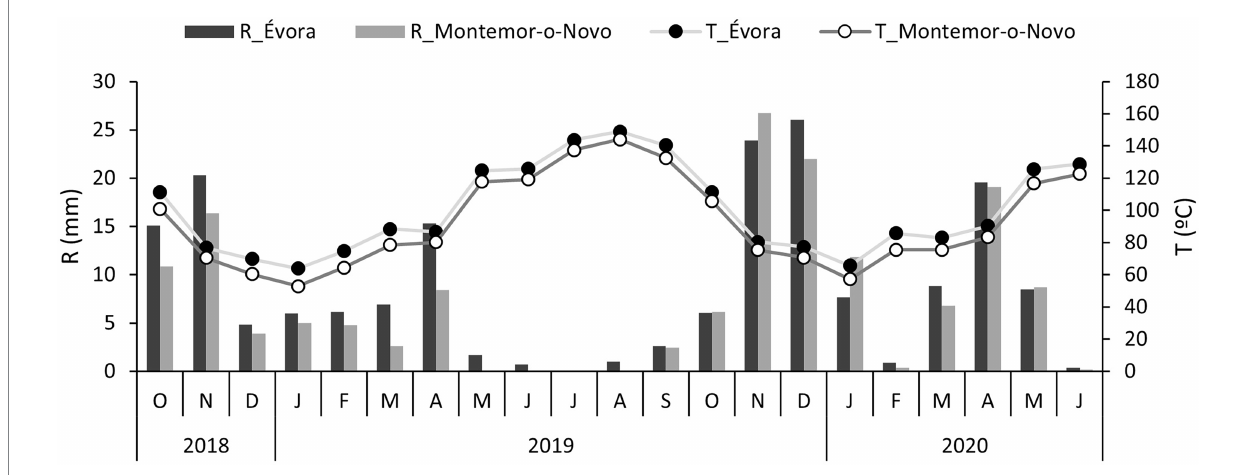
FIGURE 2 Total monthly rainfall (R) and mean monthly temperature (T) recorded accordingly the location of the in-situ plots (Évora or